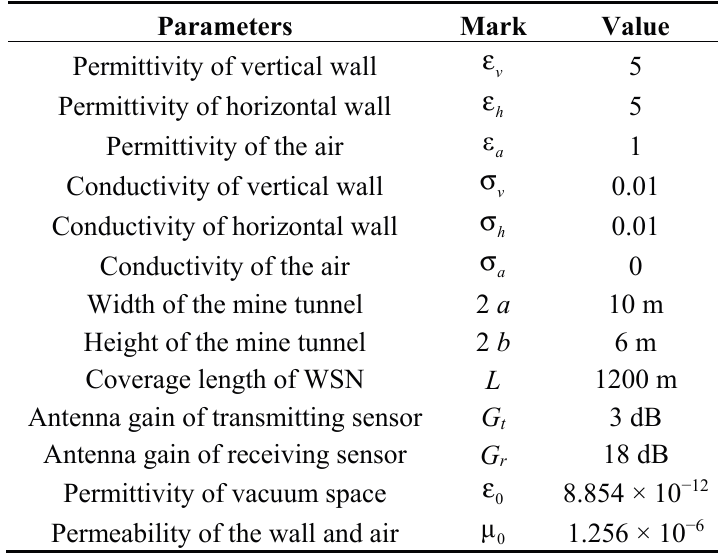
Table 1. The simulation parameters of the mine tunnel.